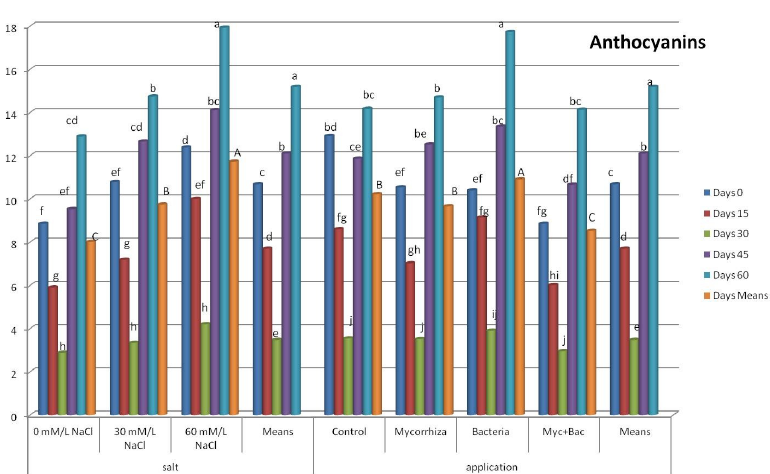
Fig. 5: Anthocyanins in the leaf tissues of strawberry cv. ‘San Andreas’ plants under salt (0, 30 and 60 mM/L NaCl) stress and applications (control, mycor- rhiza, bacteria and myc+bac) for the periods of 0, 15, 30, 45 and 60